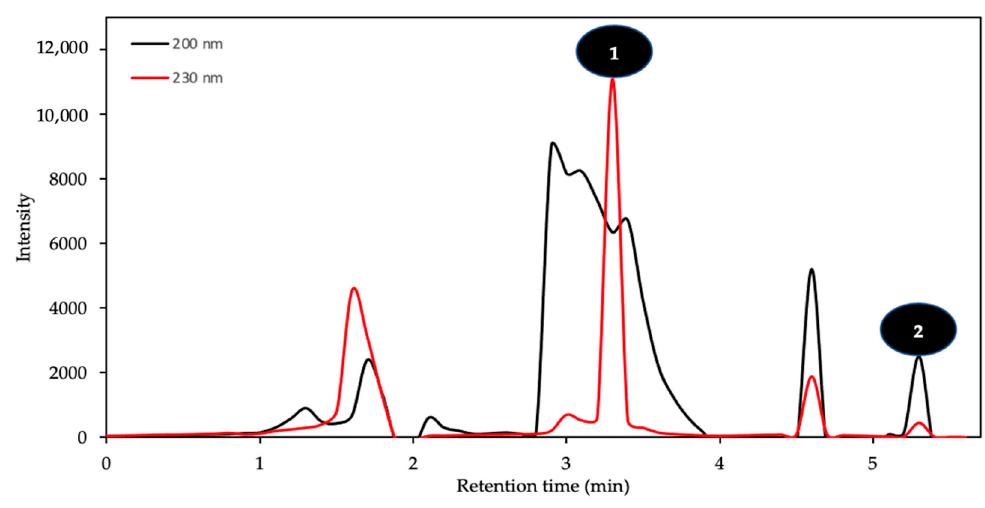
Figure 8. Naproxen (1) and ibuprofen (2) chromatograms 1 × 10 3 μ g/L at 200 and 230 nm.